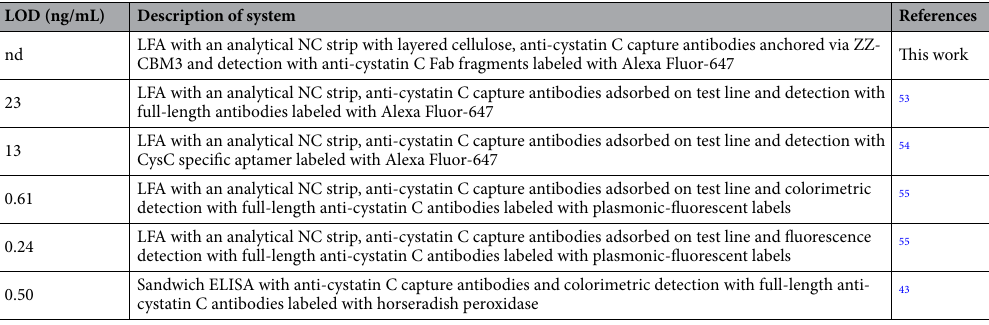
Table 1. Comparison of reported LFAs used for cystatin C detection. A cystatin C ELISA is also